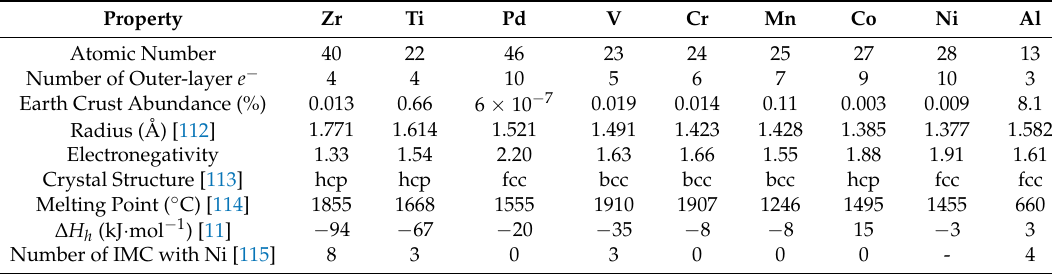
Table 2. Properties of Pd and other constituent elements in the alloys of this study. The radius quoted here is the atomic radius found in the Laves phase. Hcp, fcc, and bcc stand for hexagonal, face-centered-cubic, and body-centered cubic structures, respectively. ∆ H h is the heat of hydride formation. IMC denotes intermetallic compound. Ni forms a solid solution with a continuous composition range and has no IMC with Pd, Cr, Mn, or